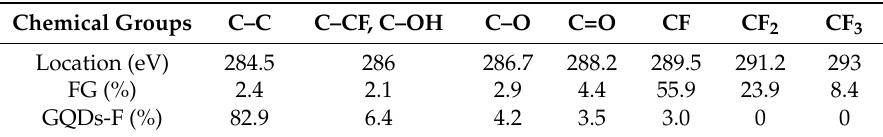
Table 1. The locations and contents of chemical groups in the samples determined from the integral intensities of C 1s XPS